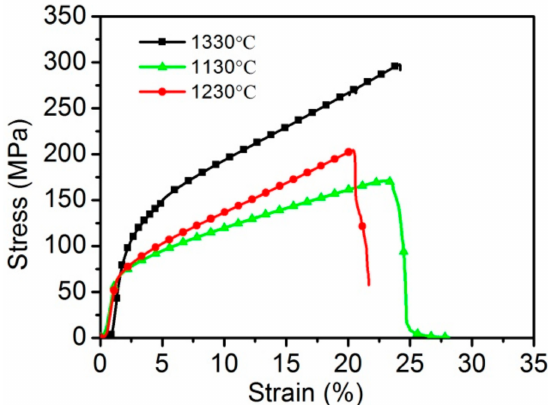
Figure 7. The uniaxial tensile stress-strain curves for the sintered wire mesh porous plates with different sintering